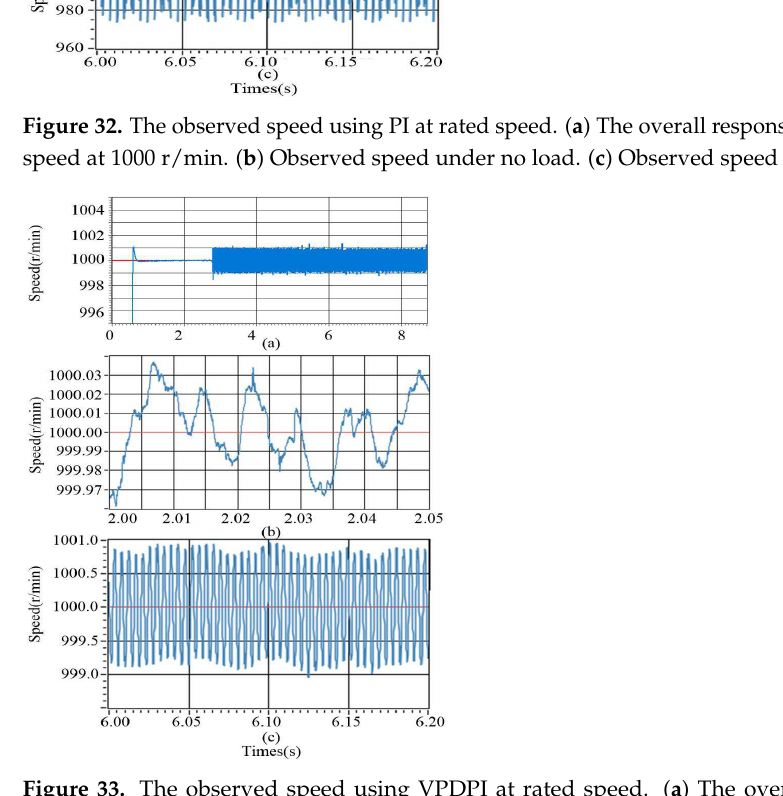
Figure 33. The observed speed using VPDPI at rated speed. ( a ) The overall response diagram of observed speed at 1000 r/min. ( b ) Observed speed under no load. ( c ) Observed speed under 2 N m ·